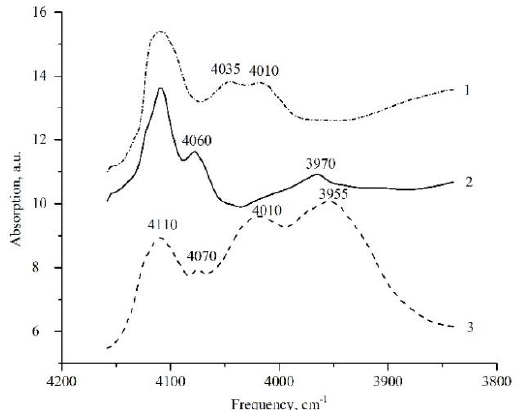
Figure 1. IR spectra of H 2 adsorbed at 77 K on: (1) Dehydroxylated HZSM-5 zeolite; (2) Cu/HZSM-5; (3) Zn/HZSM-5.